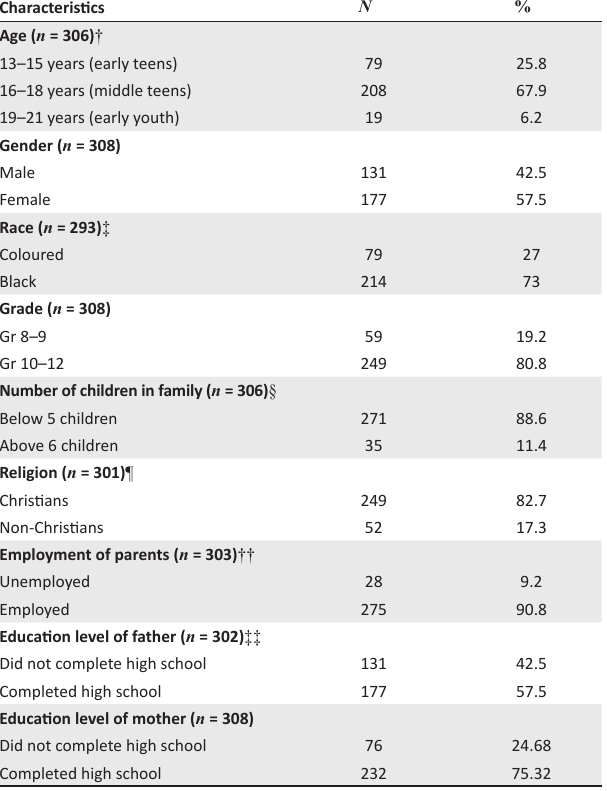
TABLE 1: Descriptive socio-demographic characteristics of the sample ( n = 308).